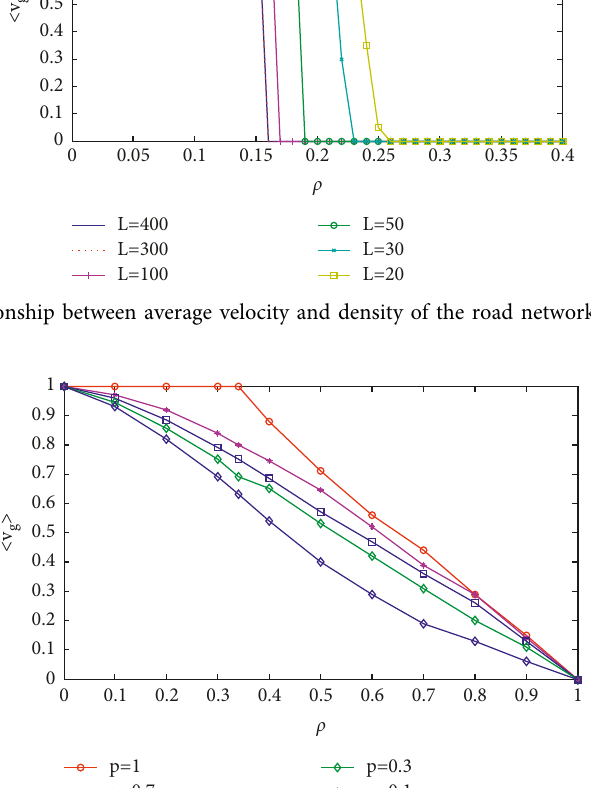
� p � 100. ur ru and L